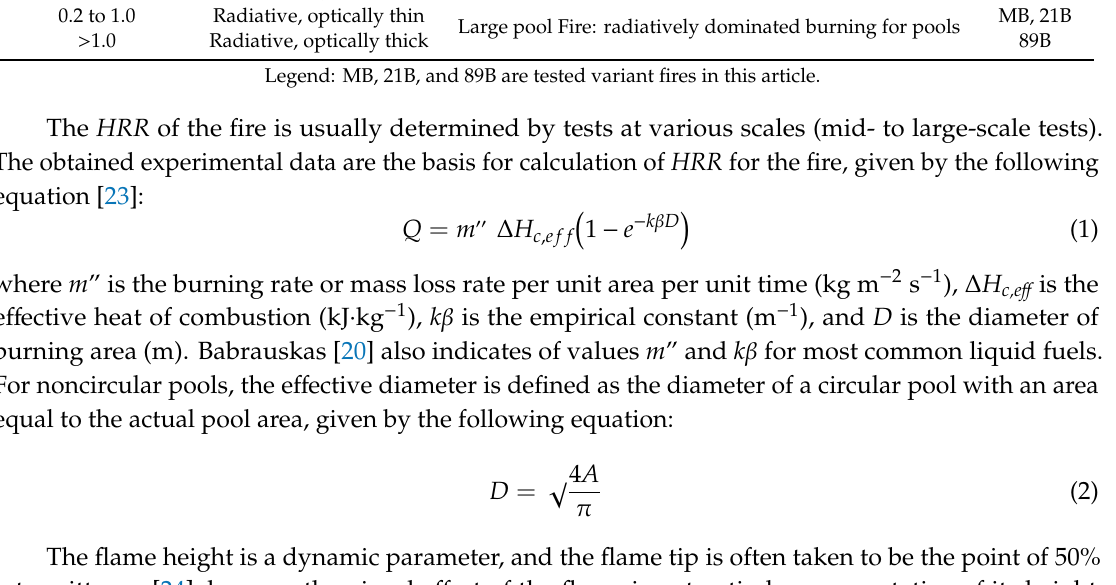
Table 1. Determination of small or large pool fire on basic HRR by selected authors. Babrauskas [20] Steinhaus et al. [11] Diameter D (m) Burning Mode Burning Regime < 0.05 Convective, laminar Small pool fire: convectively dominated burning for pools 0.05 to 0.2 Convective, turbulent 0.2 to 1.0 Radiative, optically thin Large pool Fire: radiatively dominated burning for pools > 1.0 Radiative, optically thick 89B Legend: MB, 21B, and 89B are tested variant fires in this